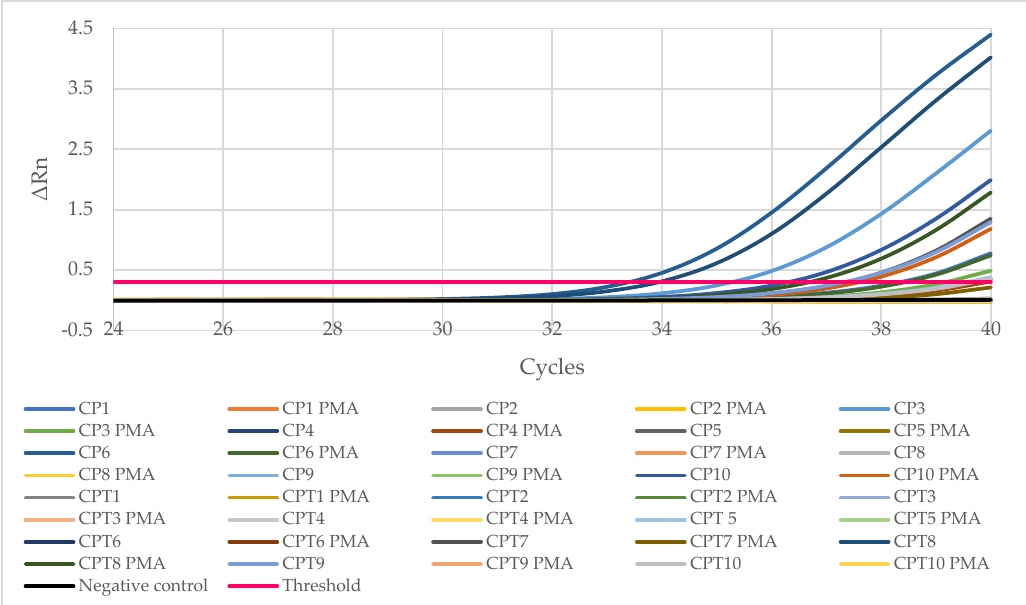
Figure 1. Chart of the amplification of samples of Listeria monocytogenes with q-PCR. All twenty samples of minced chicken, with and without the PMAxx marker, are included, together with a negative control, and the value for the threshold of fluorescence.